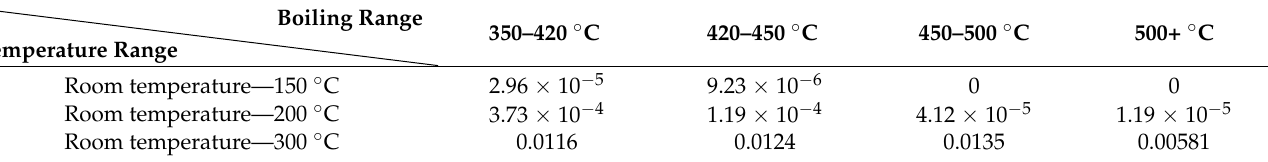
Table 4. Carbonaceous gas production of pseudo-components at different temperature ranges